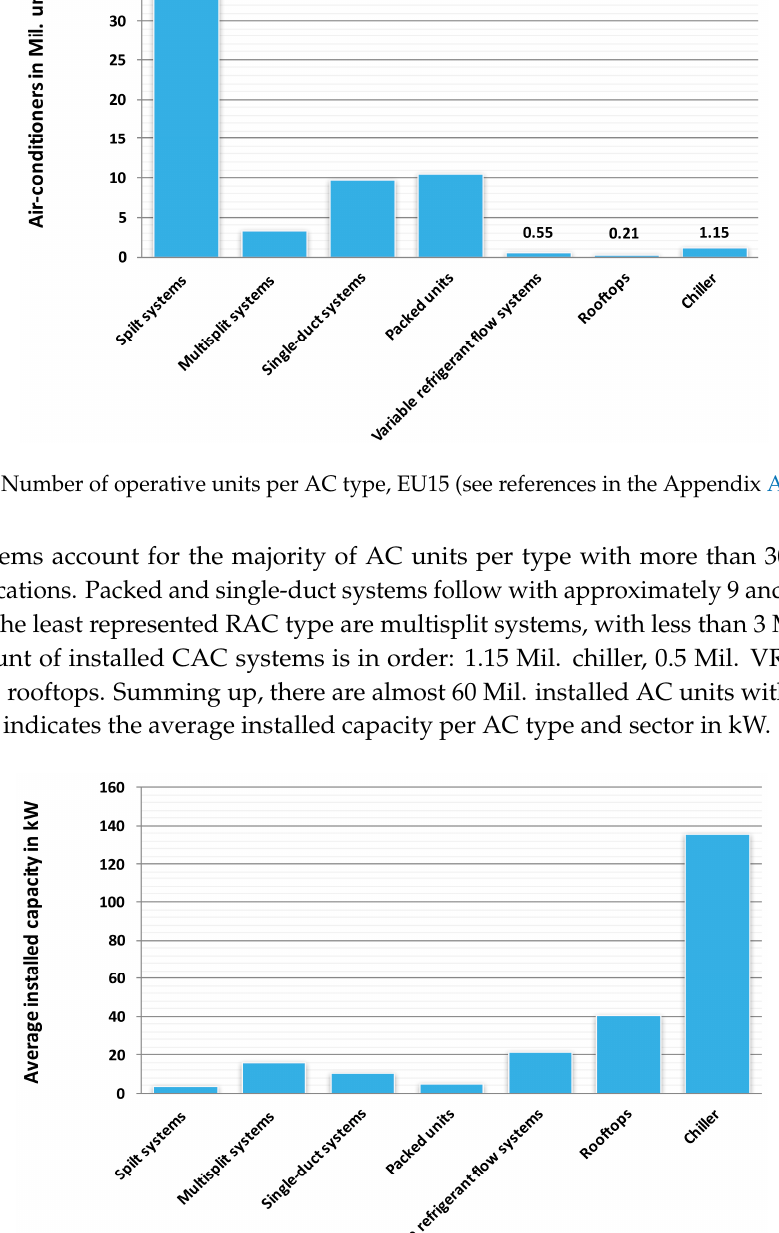
Figure 11. Average installed capacity per AC type and sector, EU15 (see references in the Appendix A, Table A4).